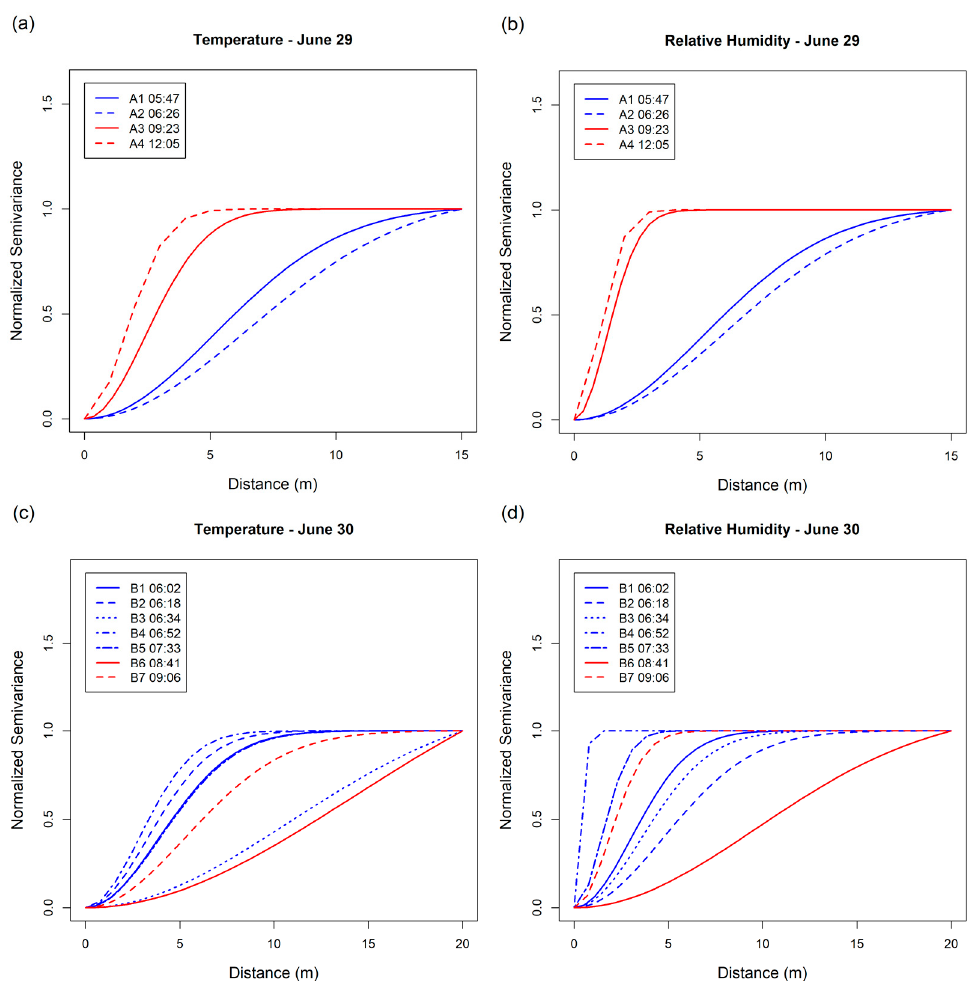
Figure 8. Standardized variogram models for ( a ) June 29 temperature, ( b ) June 29 relative humidity, ( c ) June 30 temperature, and ( d ) and June 30 relative humidity.